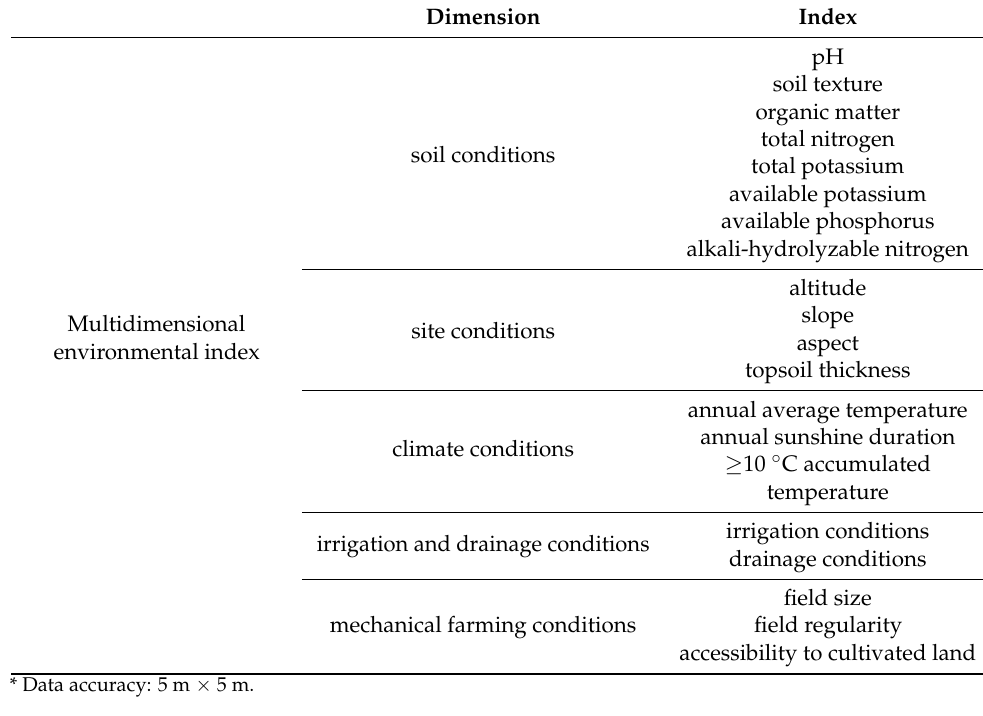
Table 1. Multidimensional environmental index dataset *.